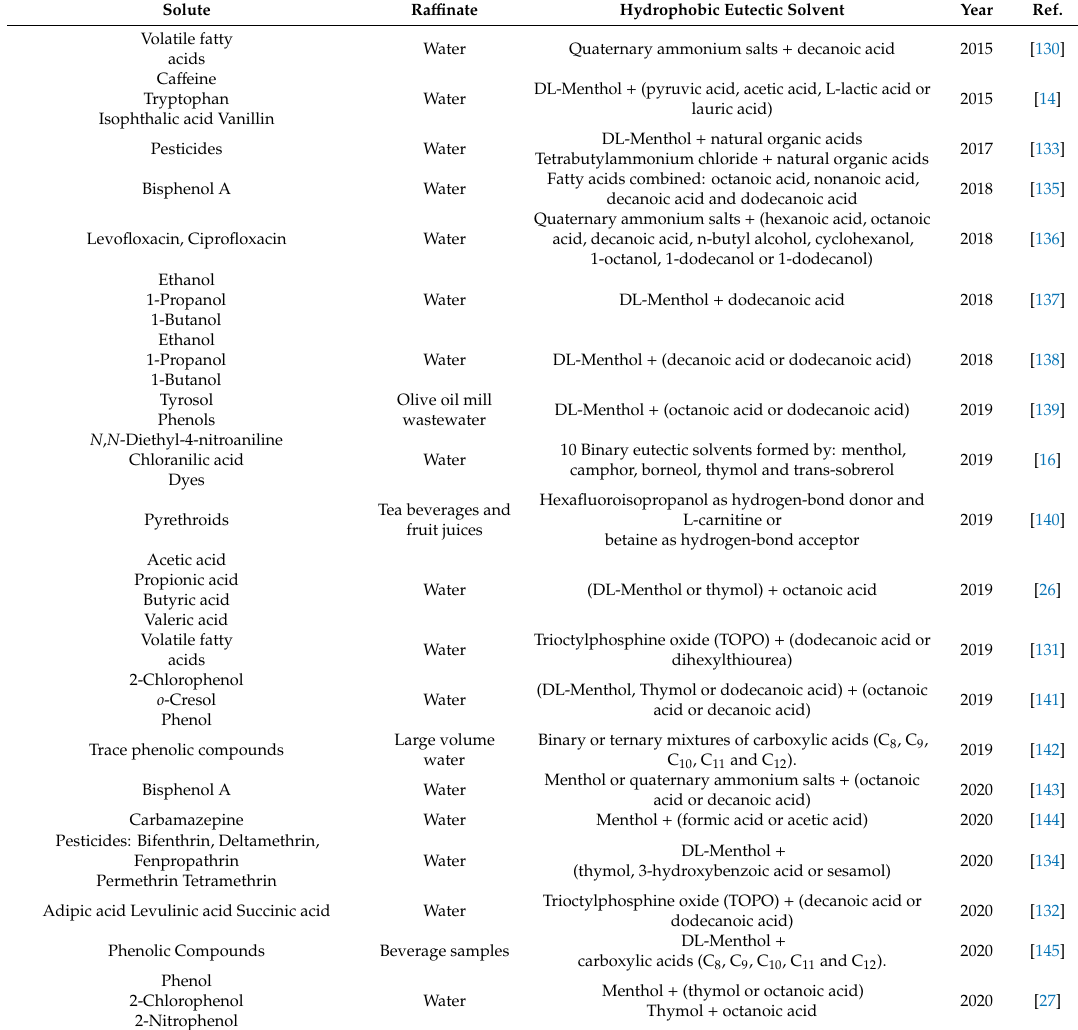
Table 8. Extraction of Organic Compounds Using Hydrophobic Eutectic